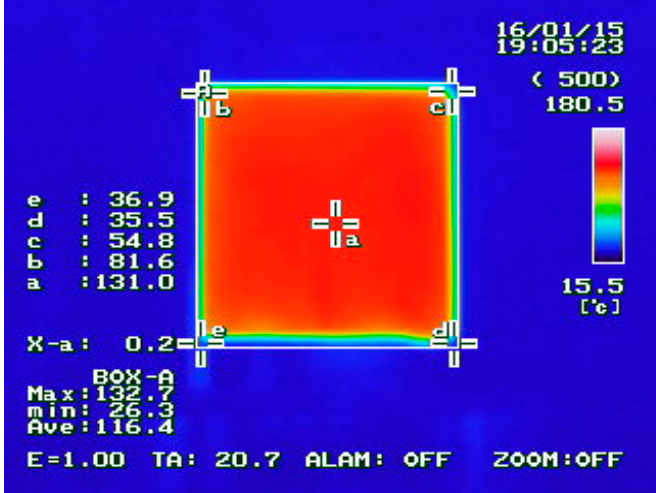
Figure 4. Example thermal image of the temperature distribution on the surface of the tested sample. Table 3. Temperature of the tested samples depending on the cooling time.